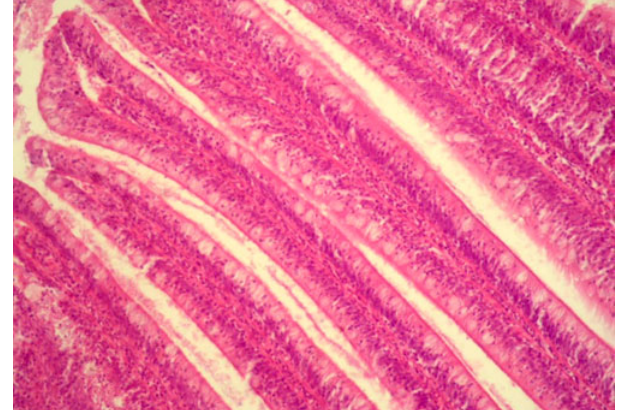
Fig. 7. Carp intestinal villi of Experiment 1 are clearly contoured and compactly placed. H&E. x 200